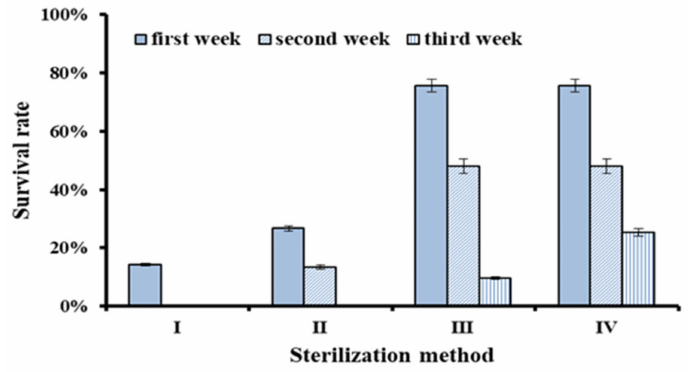
Figure 1. Explants survival rate of H. serrata for different sterilization method.